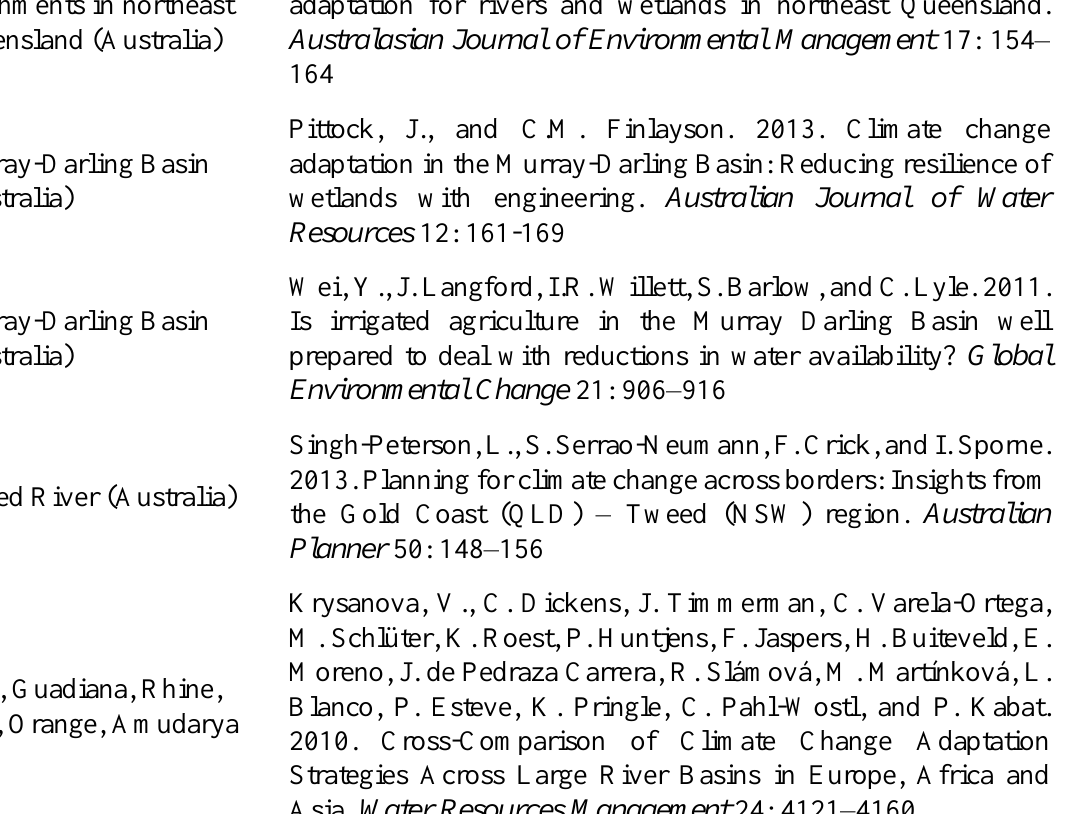
Table A1.1 Primary case studies and river